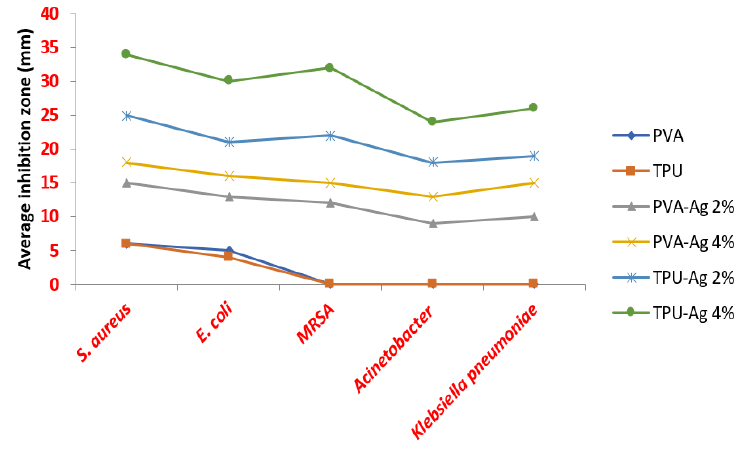
9 of 14 Figure 5. Percentage of remaining activity of blocking viral fusion of SARS-COV-2. It was recently reported [43] that nanoparticles or polymers had little or no antiviral activity on their own, but that a hybrid of both might have a lower effective viral titer. This may be due to the hybrid substance property of being a combination of modified materials rather than a hybrid of two materials in their original state. Antiviral activity was attributed to the presence of ions produced on the surface of nanoparticles. The pres- ence of reactive oxygen species in Ag NPs may produce ions that disrupt the lipid bilayer membrane's structural integrity or the virion particles surface antigens. The virus parti- cles' ability to interact with the cell surface receptor required for attachment and subse- quent entry into the host cell should be harmed as a result of this interference [44]. 3.4. Antibacterial Activity Silver nanoparticles have a wide range of applications, including wound dressings, medical device coatings, and Ag NP-impregnated textile fabrics [45]. The advantage of impregnation with Ag NPs is that silver ions are released continuously, increasing anti- microbial effectiveness. In our study, in order to investigate the antibacterial activity of PVA-Ag and TPU-Ag, different bacterial strains were explored by measuring the inhibi-